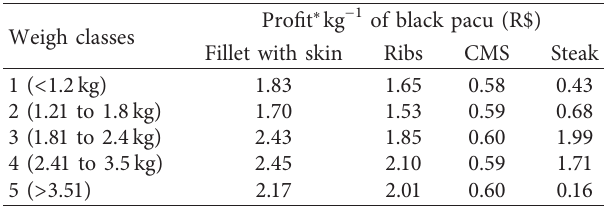
Table 2: Economic return of commercial black pacu ( Colossoma macropomum ) cuts in different weight